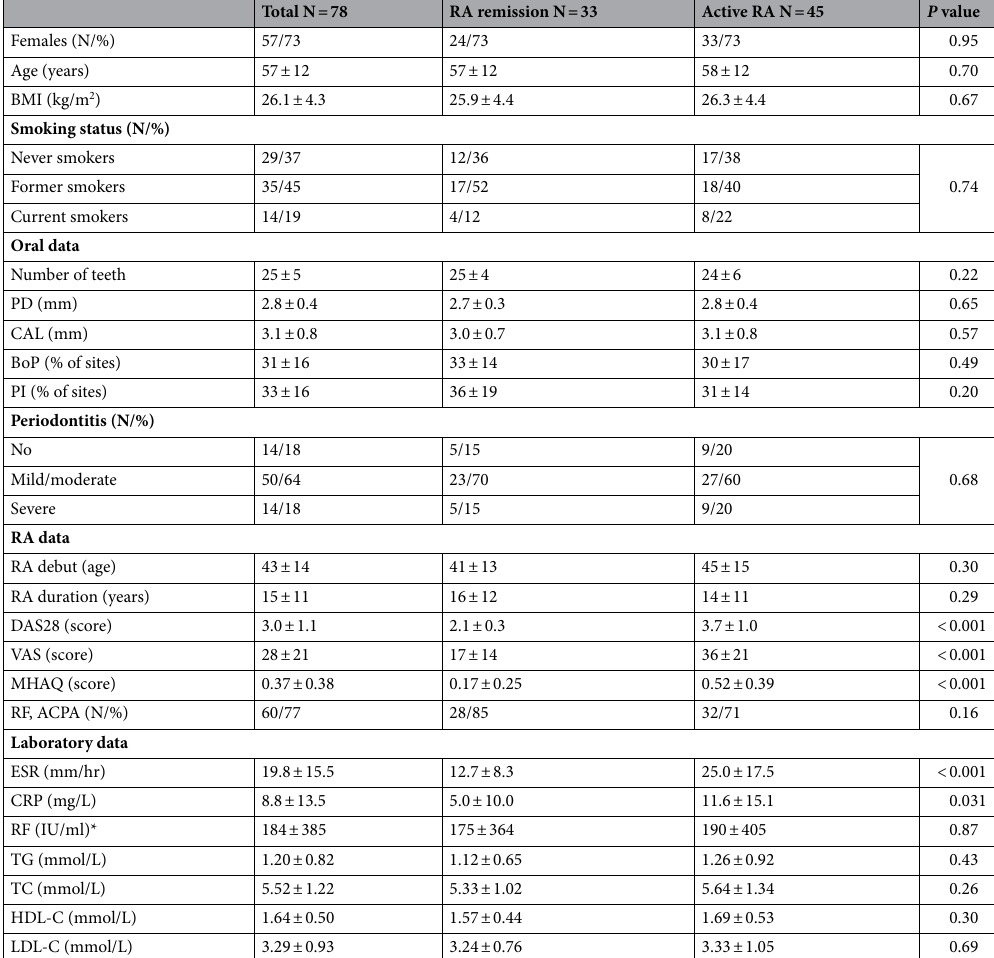
Table 1. Patient characteristics grouped by rheumatoid arthritis (RA) disease activity (DAS 28). Categorical/ continuous variables of demographic, behavioral and clinical characteristics. RA disease activity, measured as disease activity score 28 (DAS28); Remission, RA disease in remission defined as DAS28 ≤ 2.6; Active RA disease defined as DAS28 > 2.6; N, number; Age, patient’s age in years at the time of clinical examination; BMI body mass index, PD probing depth, CAL clinical attachment level, BoP bleeding on probing, PI plaque index, DAS28 disease activity score 28, VAS patient global health assessment score on a visual analogue scale, MHAQ modified health assessment questionnaire, RF, ACPA, seropositivity, positive tests for rheumatoid factor (RF) ( N = 74) and/or anti-citrullinated protein antibody (ACPA) ( N = 77); ESR erythrocyte sedimentation rate, CRP C-reactive protein, TG triglyceride, TC total cholesterol, HDL-C high-density lipoprotein cholesterol, LDL-C low-density lipoprotein cholesterol. Analysed with Pearson chi-square and Student t-test: P -level < 0.05. *n =